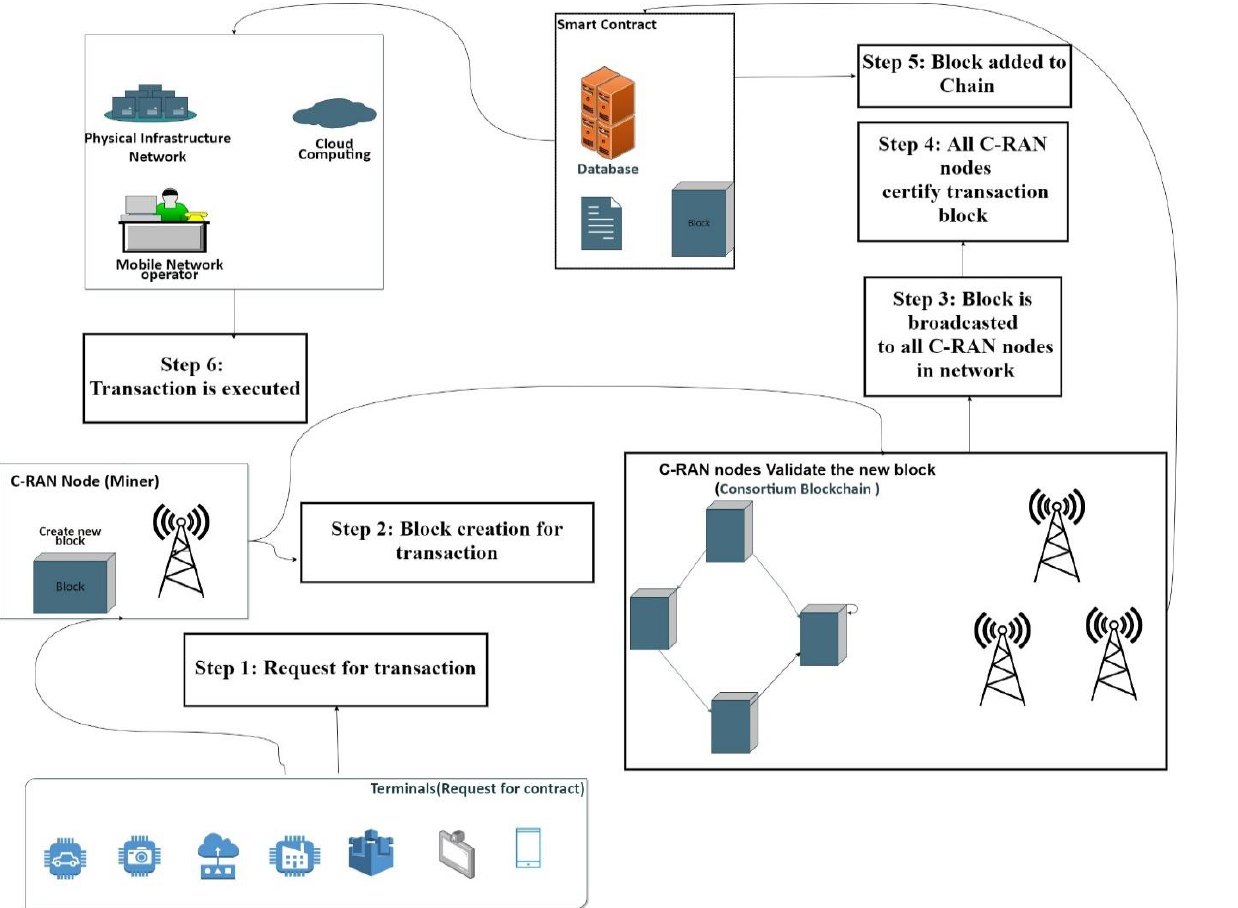
Figure 3. Consortium blockchain for the C-RAN